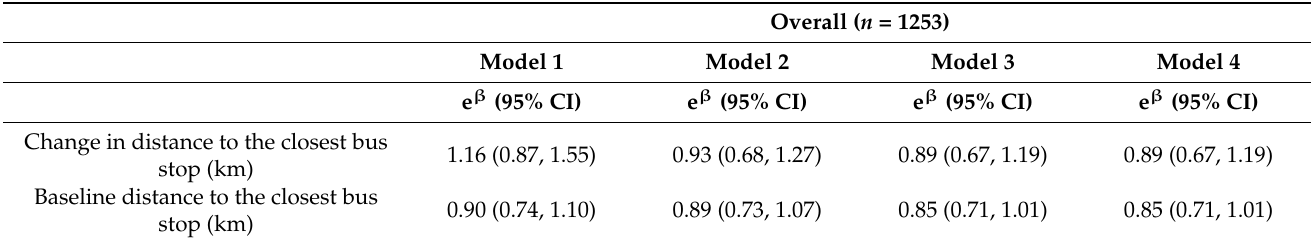
Table A4. Results from sensitivity analysis with extreme values